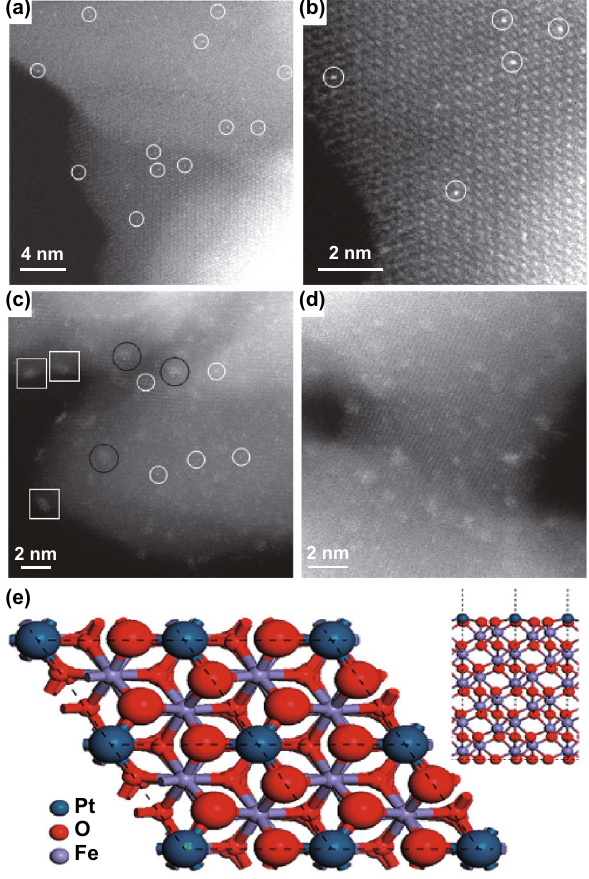
Fig. 1 a Pt SACs are uniformly distributed on the FeO x and b directly occupy the positions of the Fe atoms. c , d A mixture of SACs (in white circles), 2D Pt rafts consisting of less than ten Pt atoms (in black circles) and the size of 3D Pt clusters about 1 nm or less (white squares) are seen clearly. e DFT model of Pt 1 /FeO x . a – e Reproduced from Ref. [77] with permission. Copyright 2011 Nature Publishing